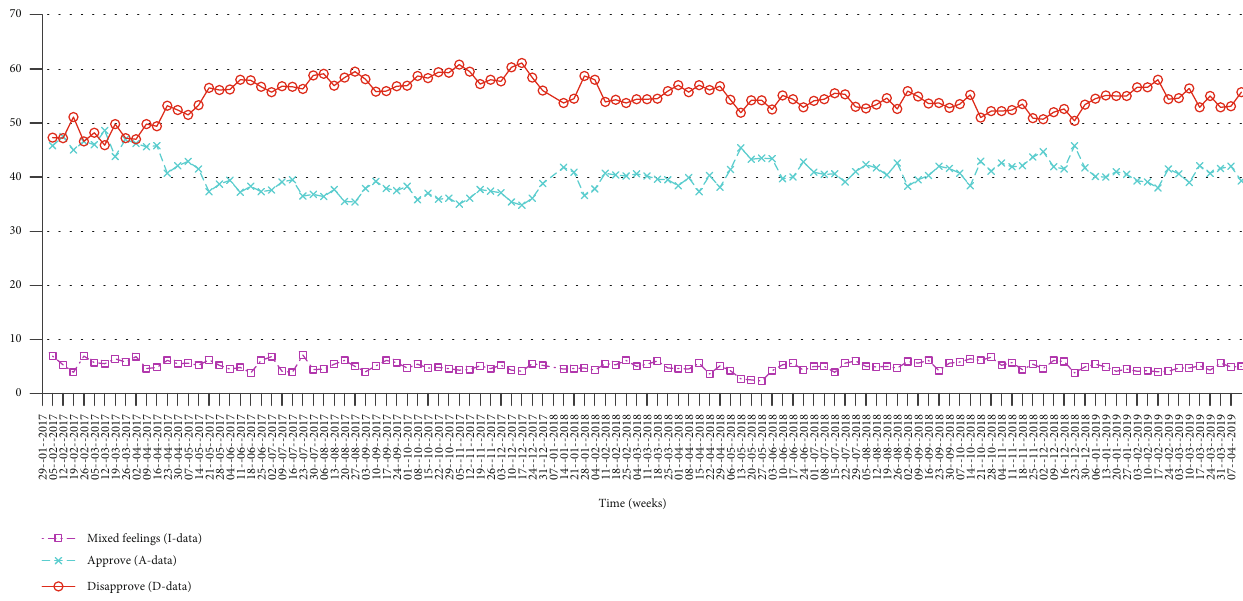
Figure 5: Data of the second poll from [20] entitled “ Overall, do you approve or disapprove about the way Donald Trump is handling his job as President?, ” see Table 4 for more details. Table 5: Estimated parameters value for models (1)-(3) for the second